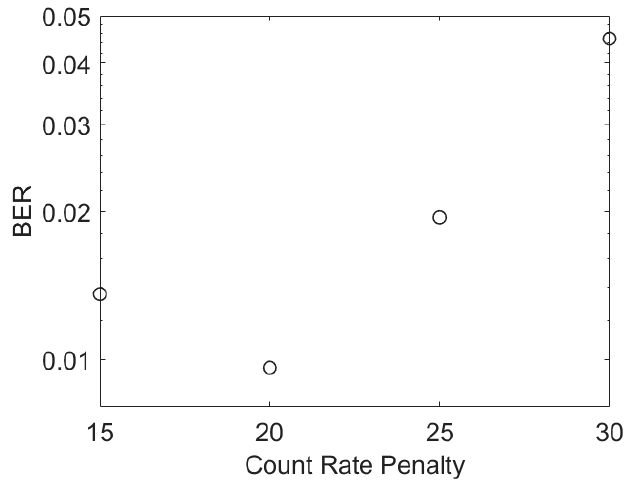
Figure 7. The simulated BER of a SiPM with the same parameters as a J30020 at 2.5